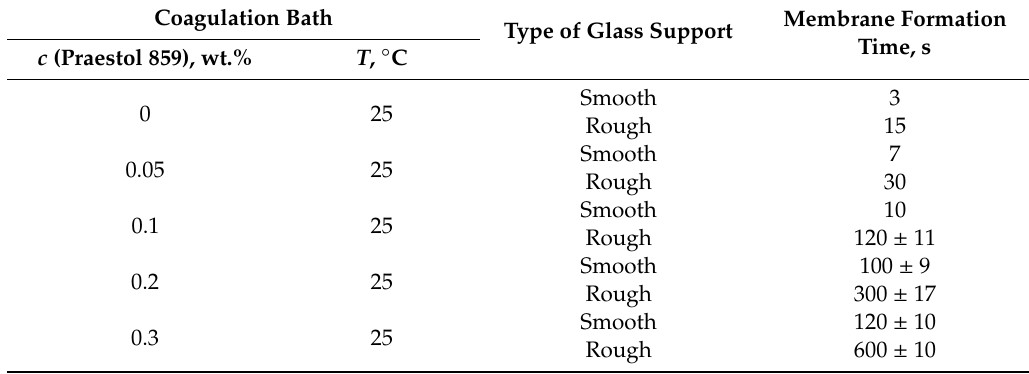
Table 3. Membrane formation time for polysulfone (PSF) membranes at different Praestol 859 concentrations and types of glass plates used in non-solvent induced phase separation (NIPS).